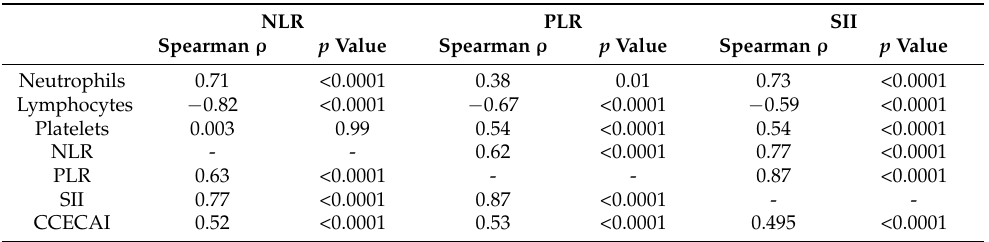
Table 2. Correlation study between the blood inflammatory markers and rest of parameters